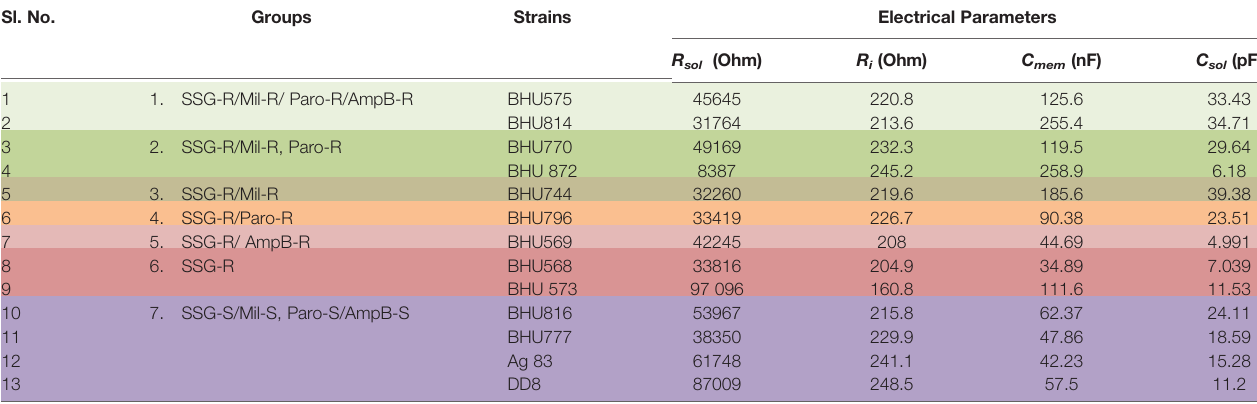
TABLE 3 | Determination of different impedimetric parameters for LD promastigotes suspended in media. Sl.